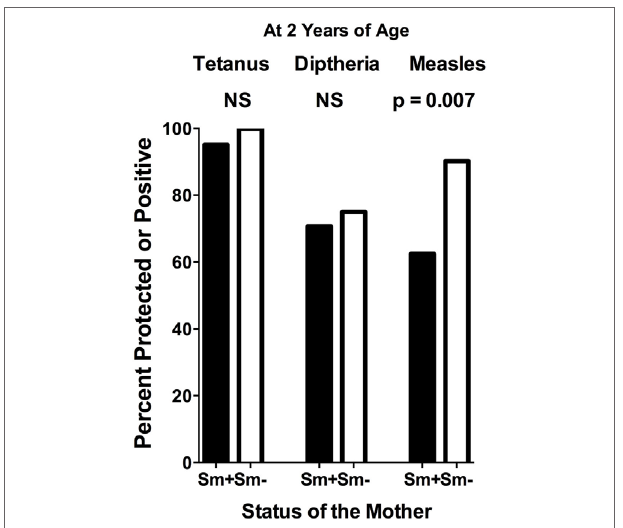
FigUre 2 | Proportion of infants at 2 years of age, born to mothers who were either egg positive (Sm + ) or egg negative (Sm − ) for Schistosoma mansoni, who had protective levels of anti-tetanus toxoid or anti-diphtheria toxoid antibodies or who were positive for anti-measles nucleoprotein antibodies in their plasma. Cutoffs to determine these levels were as follows: tetanus cutoff for protection = 10 mIU/mL = 43 median fluorescence intensity (MFI) minus background (MFI-BKG); diphtheria cutoff for complete protection = 0.1 IU/ mL = 4,103 (MFI-BKG); and measles cutoff = 67 MFI-BKG units. Comparisons were done by chi square analysis. NS, not significant.